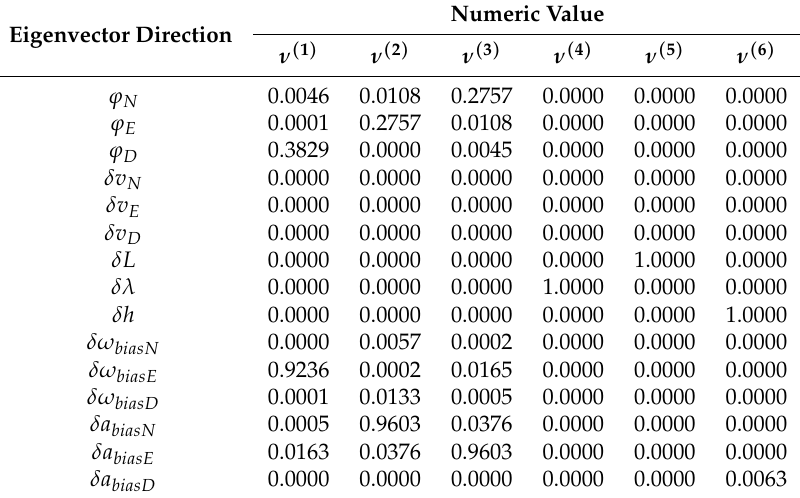
Table 2. Stationary eigenvectors ( t = 60 min) relative to the largest eigenvalues in the simulated